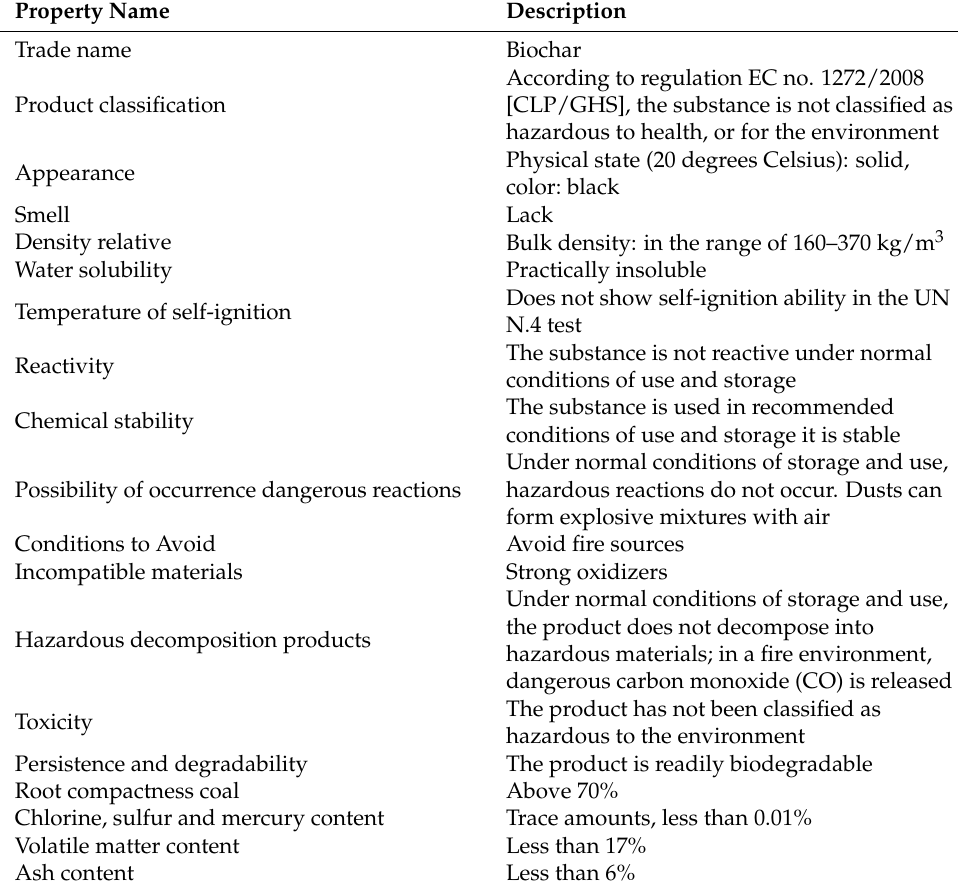
Table 1. Identification of the material used in laboratory